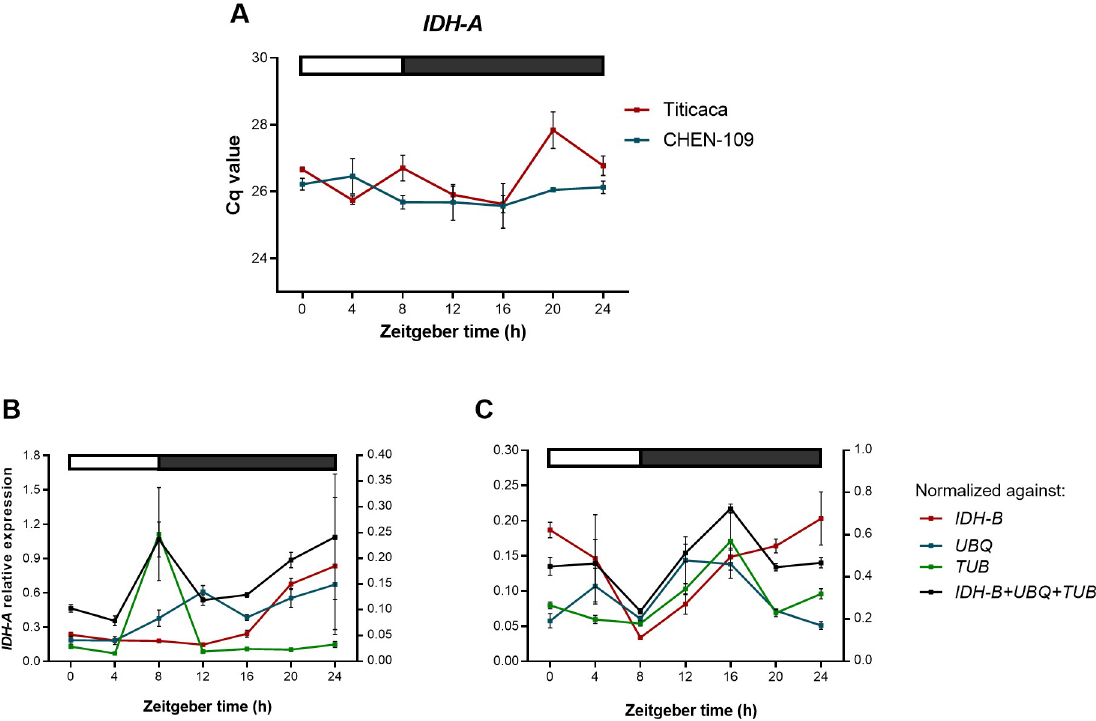
Fig 7. Illustration of a non-diurnal gene misrepresented as diurnally regulated. (A) Expression profile of IDH-A (best reference gene according to BestKeeper), which did not show cyclic expression; error bars represent standard error between biological replicates. Relative IDH-A expression normalized with each of the three least stable reference genes according to BestKeeper and their geometric mean for (B) Titicaca and (C) CHEN-109. Error bars represent the SEM between biological replicates. The bar at the top indicates light (empty box) and dark (filled box)